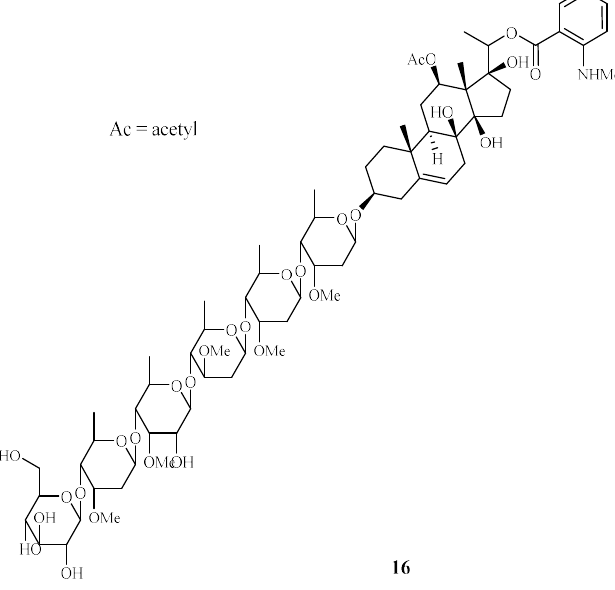
Figure 5. Compound from an Asclepiadaceae plant.